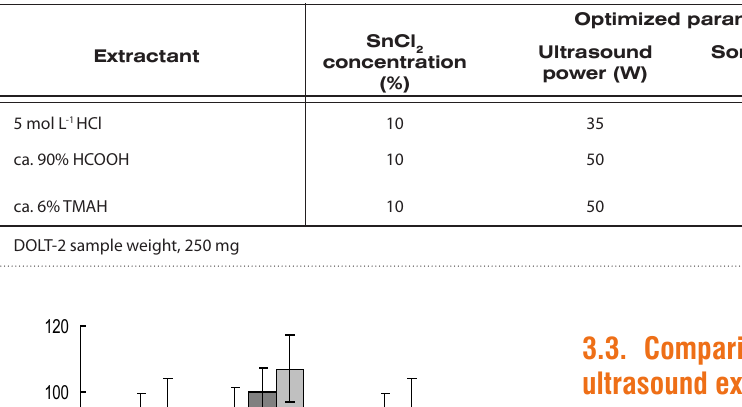
Table 2. Optimized ultrasound extraction